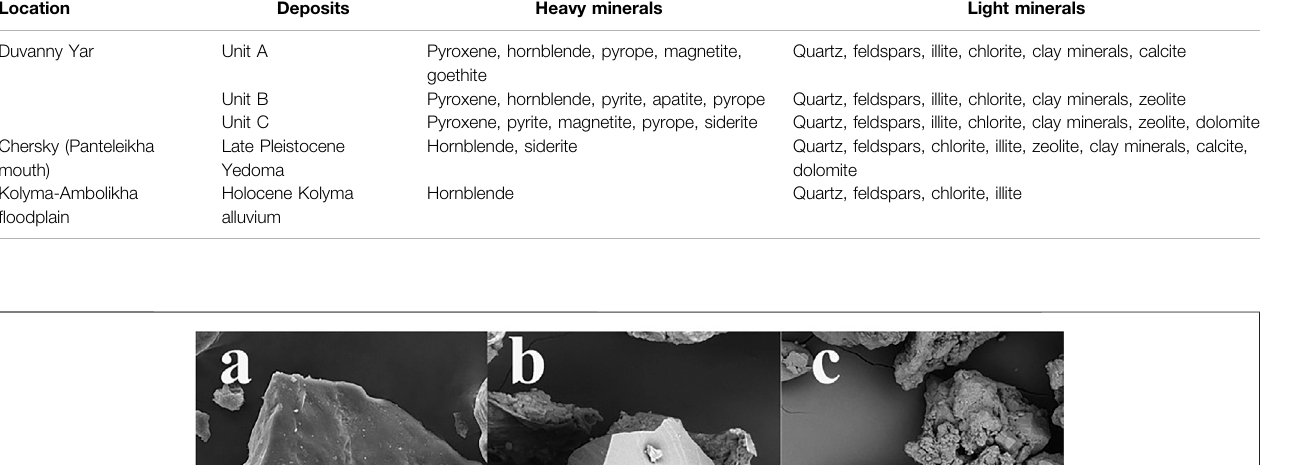
TABLE 2 | Mineral composition in 10 – 100 µm grain size classes of Duvanny Yar sediments (this study) and comparison to Kolyma alluvium and Chersky Yedoma deposits (Shmelev et al., 2013). Location